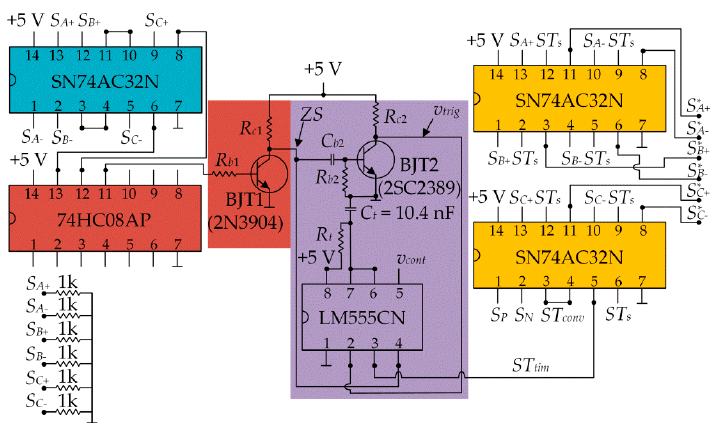
Figure 5. Electrical diagram of the PWM pulses generation with the STSs injection by means of both the zero-sync and conventional methods. A monostable operation mode of the timer LM555CN (Texas Instruments) is im- plemented in order to ensure desired half STS period ( T 0 /2) in the zero-sync method. In this operation mode, the timer output (pin 3), which is utilized as the signal ST tim , is set to +5 V in the case when the voltage value of 0 V is applied to the trigger input (pin 2). The trigger input signal ( v trig ) is generated by utilizing the NPN BJT2 2SC2389 (Rohm). At the beginning of the ZSS, the BJT1 turns off which causes the ZS value to become +5 V. The current instantaneously starts to flow from the supply terminal (+5 V) through R c 1 and C b 2 = 100 pF into the base of the BJT2. That initiates the start of C b 2 charging and the BJT2 turns on (note that R c 2 = 5.6 k Ω ensures adequate BJT2 collector current), which results in v trig = 0 V. This triggers the timer and the ST tim value changes to +5 V, which represents the start of the STS. As a result, the timer pins 6 and 7 internally disconnect from the pin 1, which is connected to the ground. Therefore, the capacitor C t , connected between the timer pins 6 and 7 and the ground, begins to charge through the resistor R t , connected between the timer pins 8 (supply +5 V) and 6 and 7. During the STS, the v trig value remains 0 V as long as the base current is high enough to maintain the BJT2 turned on, practically until C b 2 is fully charged. Once C b 2 is fully charged, the BJT2 turns off and the v trig value becomes +5 V. In the considered circuitry, the v trig value remains 0 V for approximately 1.5 μ s within each ZSS, which is determined by the time constant R c 1 C b 2 and BJT2 pa- rameters such as the base-collector voltage and the current transfer ratio of the base cur- rent. The value of the timer output ( ST tim ) remains +5 V until the voltage across C t ( v Ct ) reaches the value of the signal applied to the timer pin 5 ( v cont ). At that point, the ST tim value becomes 0 V (STS ends) and retains that value until the next STS. As the ST tim value changes to 0 V, the timer pins 6 and 7 internally connect to the pin 1 (ground) and thus enable C t discharge. Note that for the proper operation of the timer, the v trig value has to be +5 V at the moment when v Ct reaches v cont . Therefore, each STS generated by the timer in considered circuitry has to last longer than 1.5 μ s. Finally, at the end of the ZSS, the BJT1 turns on, the ZS value changes to 0 V, and C b 2 discharges through R b 2 = 10 k Ω and BJT1. In this way, the multiple trigger occurrences within a single ZSS are prevented. The implemented circuitry allows the STS to last equal or lower than the ZSS. This is achieved by utilizing the ZS signal to control the reset of the timer (pin 4). If the reset is set to 0 V, the timer output is disabled (pin 3 is permanently set to 0), whereas if the reset is set to +5 V, the timer operates regularly. The STS signal ( ST s ) shown in Figure 5 is injected into the SPWM signals by means of the logic OR gates SN74AC32N. ST s is the result of the logic OR operation of ST tim and ST conv . ST conv is generated as the result of logic OR operation of S P and S N , also by utilizing